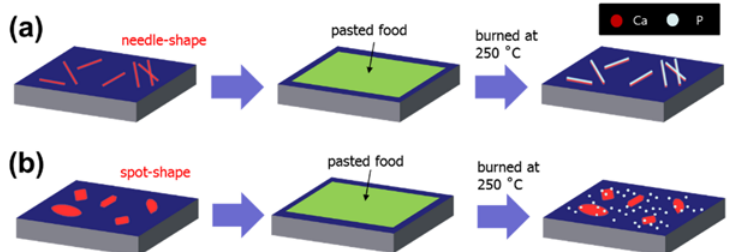
Figure 8. An illustration depicting the difference in the chemical reaction with phosphate ( a ) needle-shape and ( b ) spot-shape Ca-phases. The enamel scale (blue) The Ca-phases are represented with red, and the phosphate distribution is shown with white color. ( a ) Phosphates are distributed along the Ca-phases; ( b ) phosphates are distributed independently from the Ca ‐ phases.